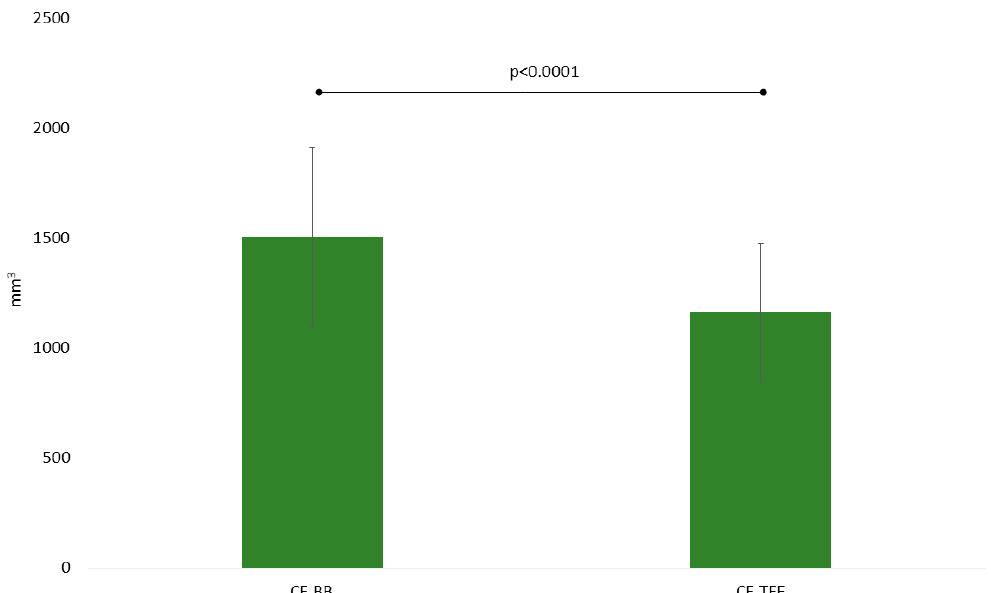
Figure 4. Mean volumes of contrast-enhancing tumor residuals for contrast-enhanced (CE) turbo field-echo (TFE) and Black Blood (BB) sequences as derived from intraoperative magnetic resonance imaging (iMRI).